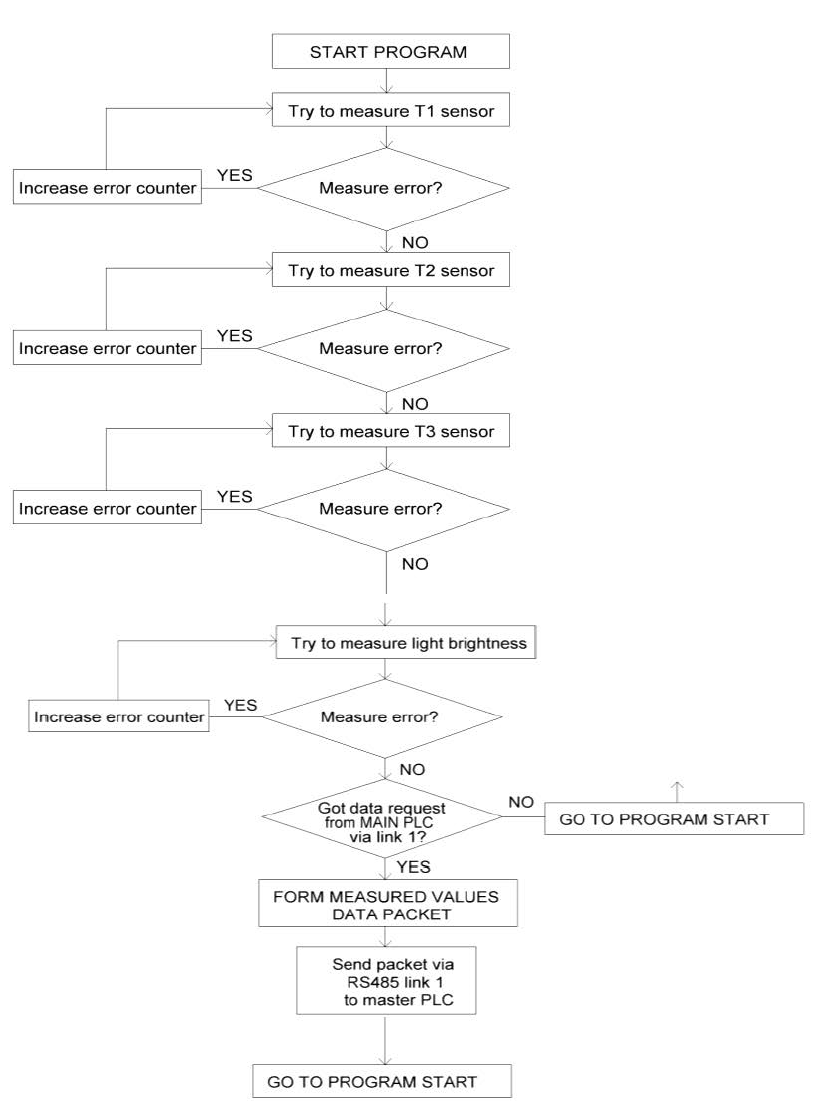
Figure 4. Operating parameter monitoring system microcontroller program operation algorithm.